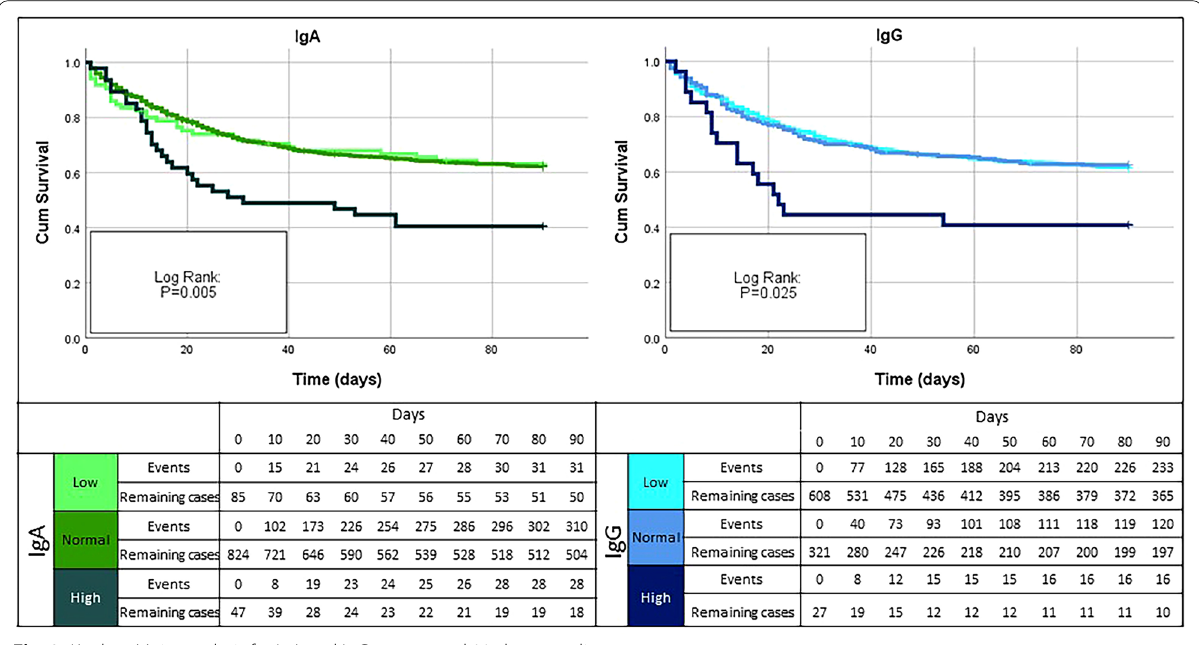
Fig. 2 Kaplan–Meier analysis for IgA and IgG-groups and 90-day mortality